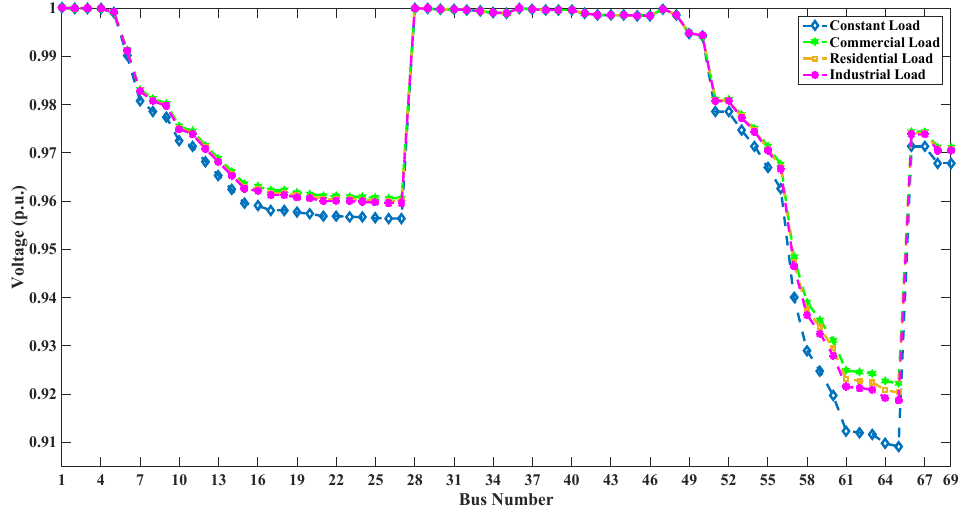
Figure 2. Variation of base-case bus voltage for all loads.